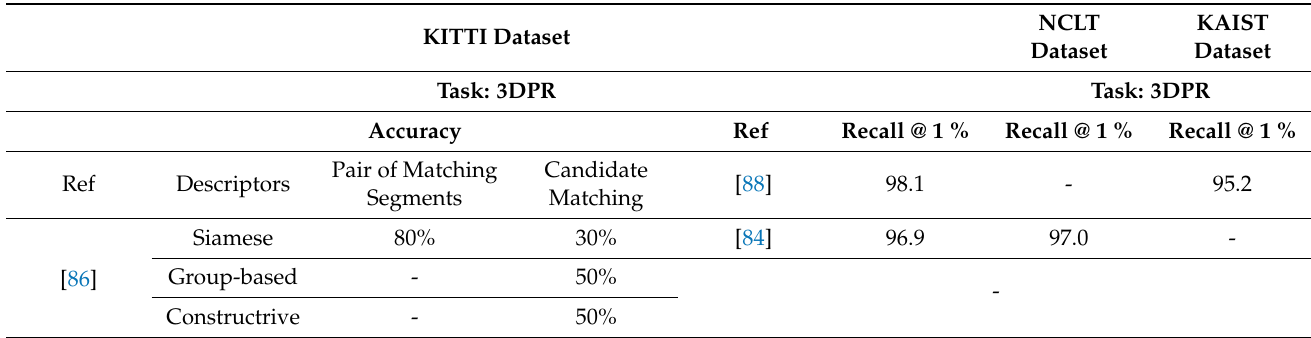
Table 25. Comparison of the Results on the KITTI, NCLT, and KAIST Datasets. KITTI Dataset